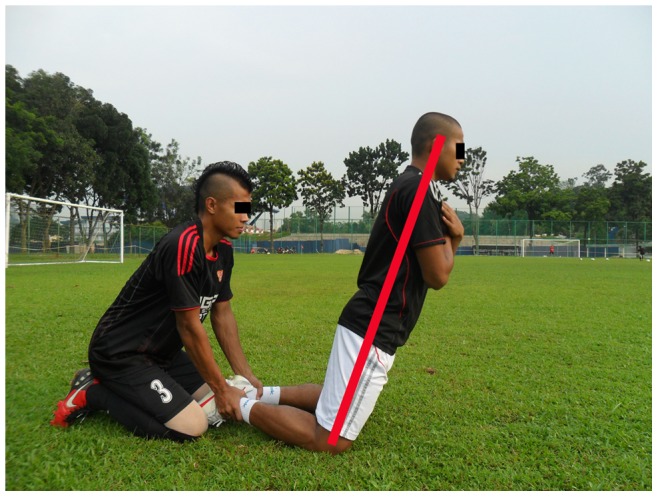
Nordic hamstring.